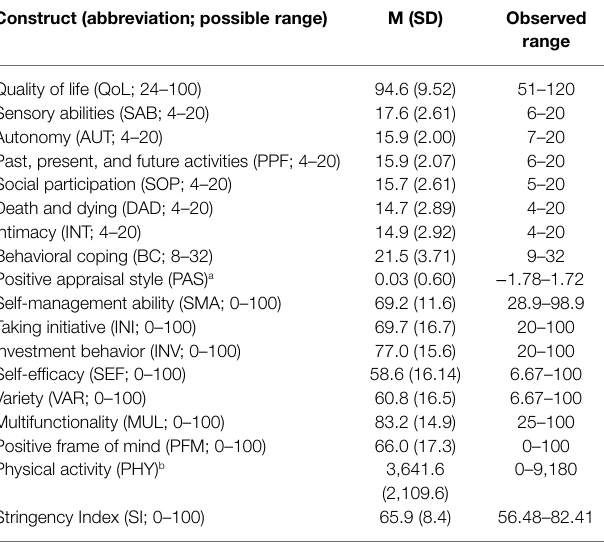
a z-score. b Composite score: physical activity duration weighted by